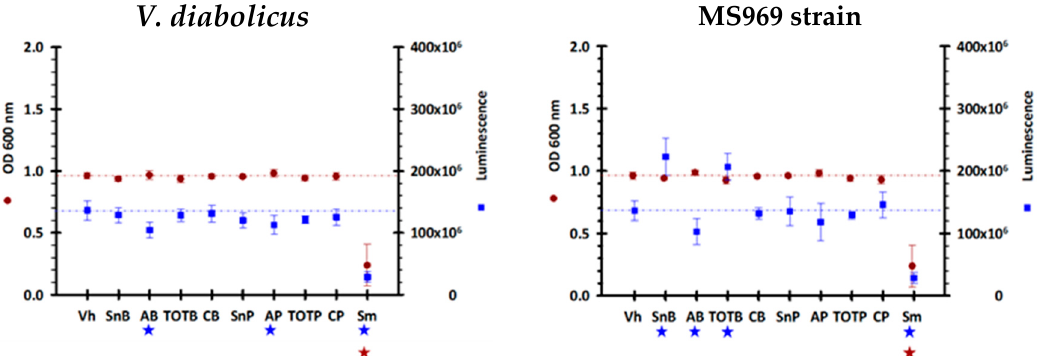
Figure 11. Effect of extracts on V. harveyi growth and luminescence. Results were registered at maximum luminescence (12 h growth). Vh: V. harveyi without the addition of the extract (reference). Sm: Streptomycin at 50 µg/mL. Blue stars: the significant effect on luminescence at p- value < 0.01. Red stars: the significant effect on growth (OD 600 nm) at p -value < 0.01. Assays were performed four times and were statistically compared to 92 assays with V. harveyi alone using Student’s test.